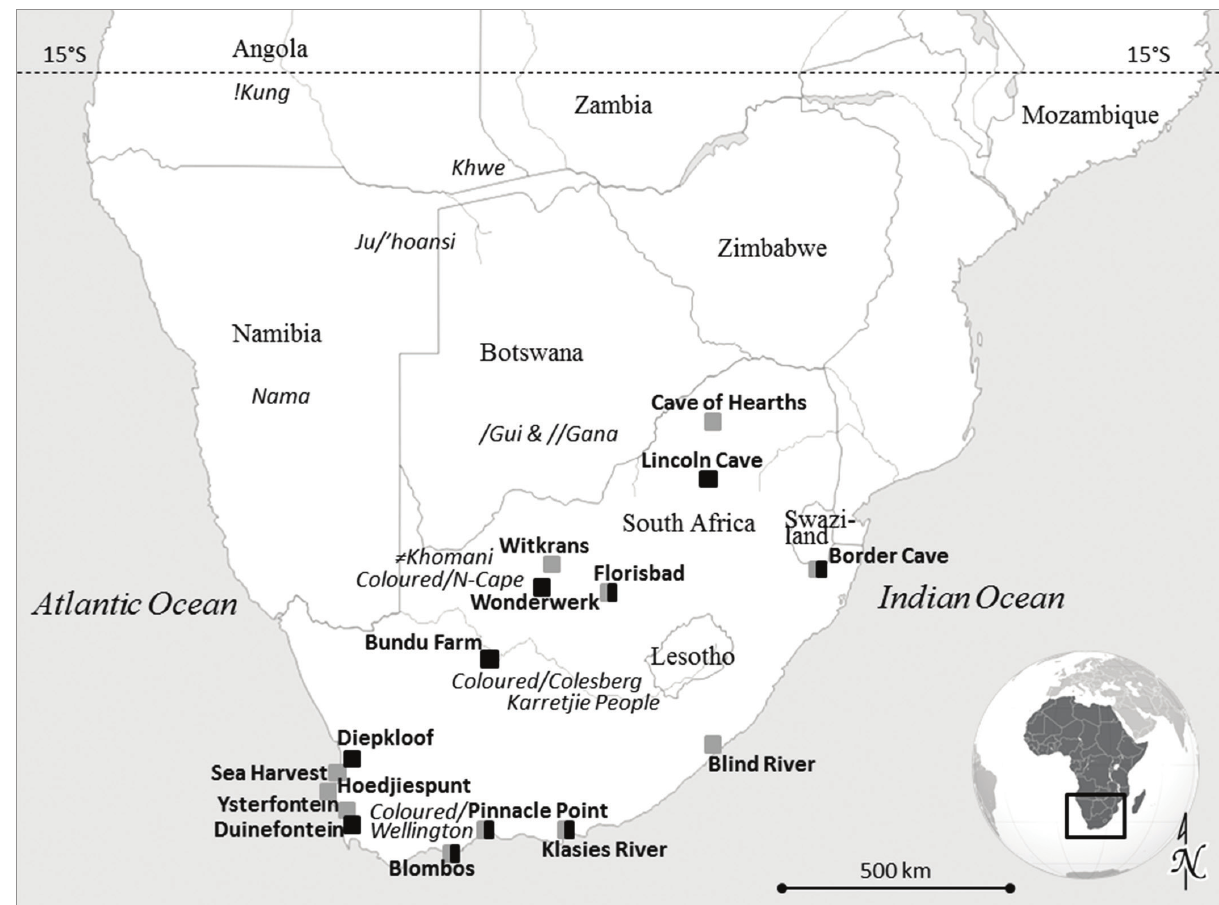
Grey squares, fossil sites; black squares, archaeological sites; grey and black squares, archaeological sites with fossil material. Figure 1: Map of southern Africa with the locations of population groups, fossil sites and archaeological sites mentioned in the text.